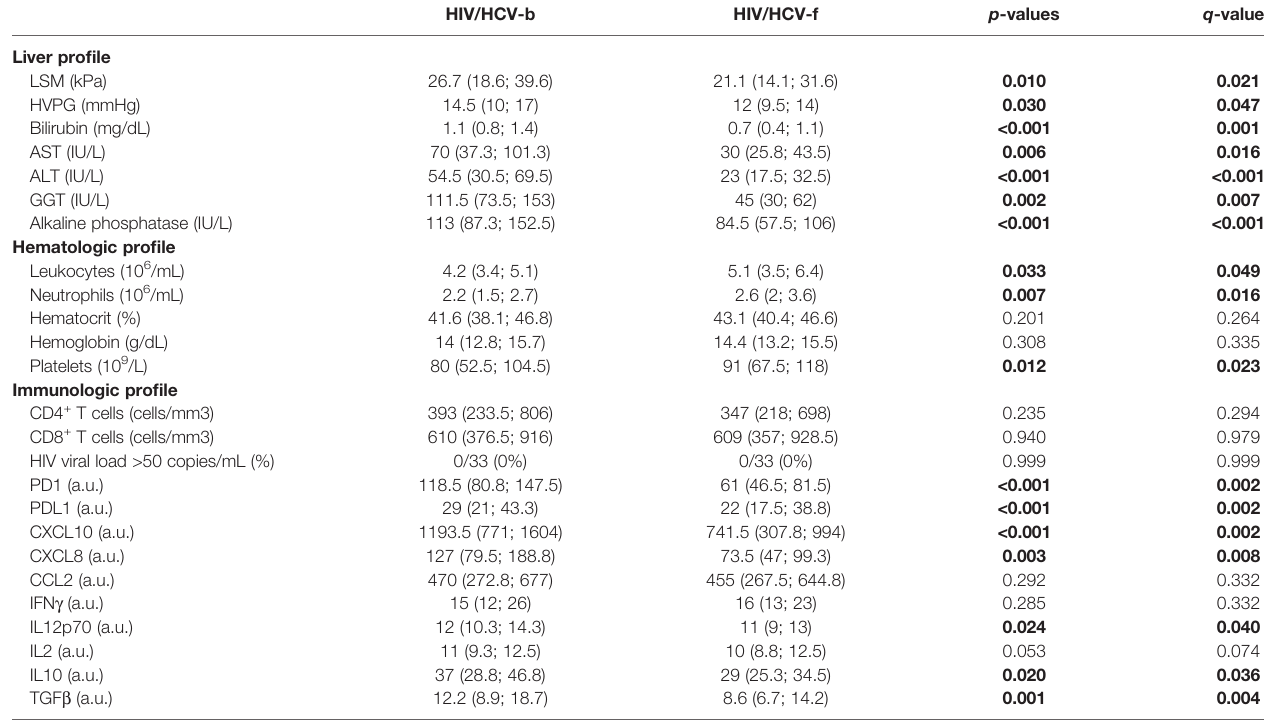
TABLE 2 | Summary of changes in disease markers in HIV-infected patients with advanced HCV-related cirrhosis during follow-up.